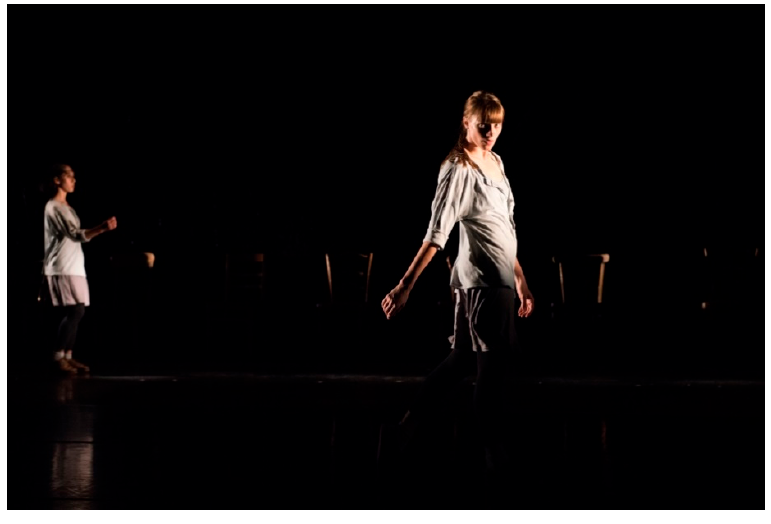
Figure 8. Rosas danst Rosas (2017) Anne Teresa De Keersmaeker / Rosas © Anne van Aerschot. Used with permission.